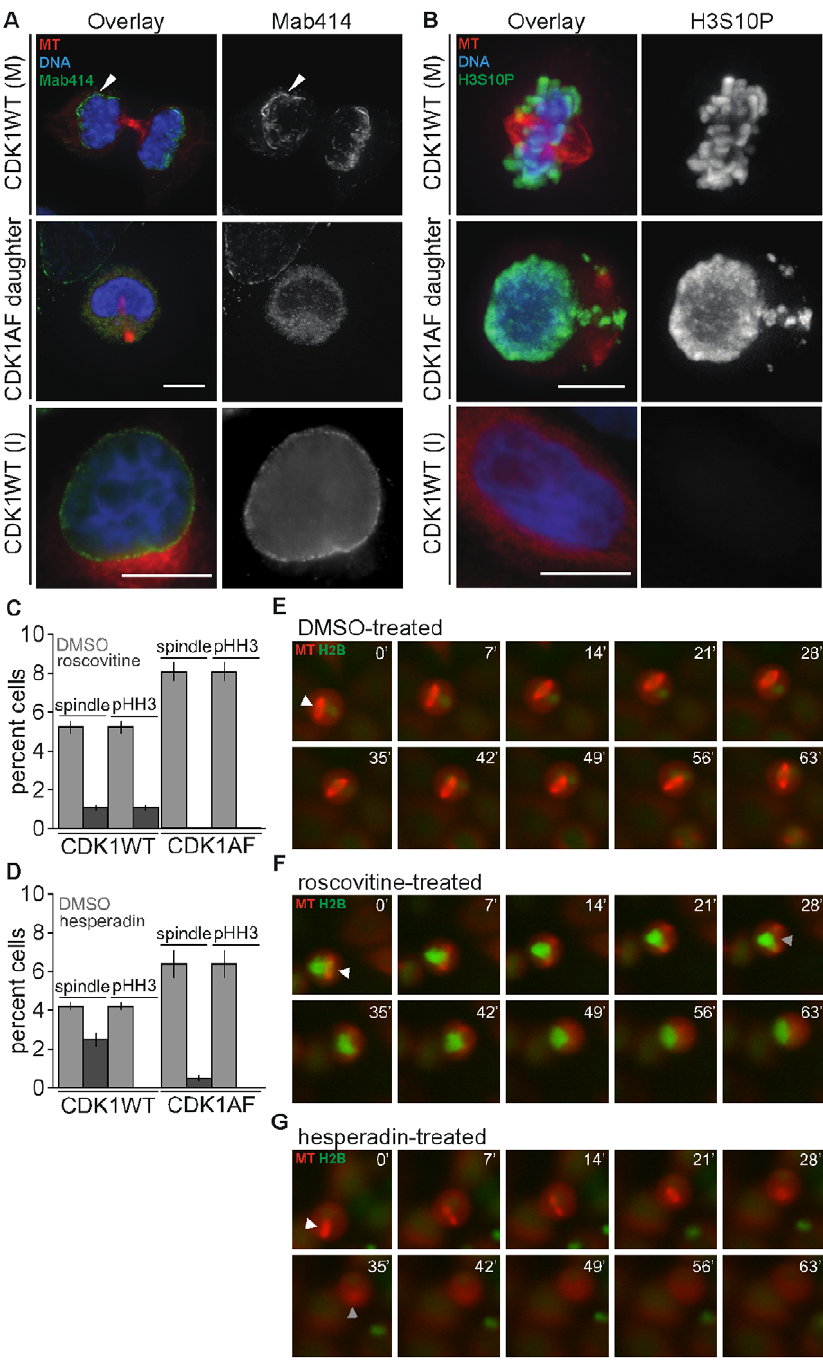
Figure 3. Premature spindle formation in G1 cells requires CDK1 and AurB activities. (A) Representative mitotic (M) and interphase (I) CDK1WT-expressing cells and a G1 cell produced by division of a CDK1AF-expresser (CDK1AF daughter), presenting microtubules (MT; red), DNA (blue), and nuclear pore complexes (Mab414; green). (B) Different cells from the population in (A), probed for pHH3 content (green). (C) Histogram of percent CDK1WT mitotic or CDK1AF M-phase-like G1 cells with spindles and/or pHH3 content after DMSO or roscovitine treatment. (D) Histogram of percent CDK1WT mitotic or CDK1AF M-phase-like G1 cells with spindles and/or pHH3 content after DMSO or hesperadin treatment. Unsynchronized HeLa cells stably expressing histone H2B-GFP (green) and mCherry- a -tubulin (red) were transfected with CFP-CDK1AF, then 24 h later were treated with DMSO, roscovitine, or hesperadin, and imaged live for 75 min (E–G). (E) M-phase-like G1 cell treated with DMSO. (F) M-phase-like G1 cell treated with roscovitine. (G) M-phase-like G1 cell treated with hesperadin. Scale bars in (A–C)=10 m M. White arrowheads in (E–G) indicate prematurely formed spindle; gray arrowheads in (F–G) indicate last image of apparent spindle structure.